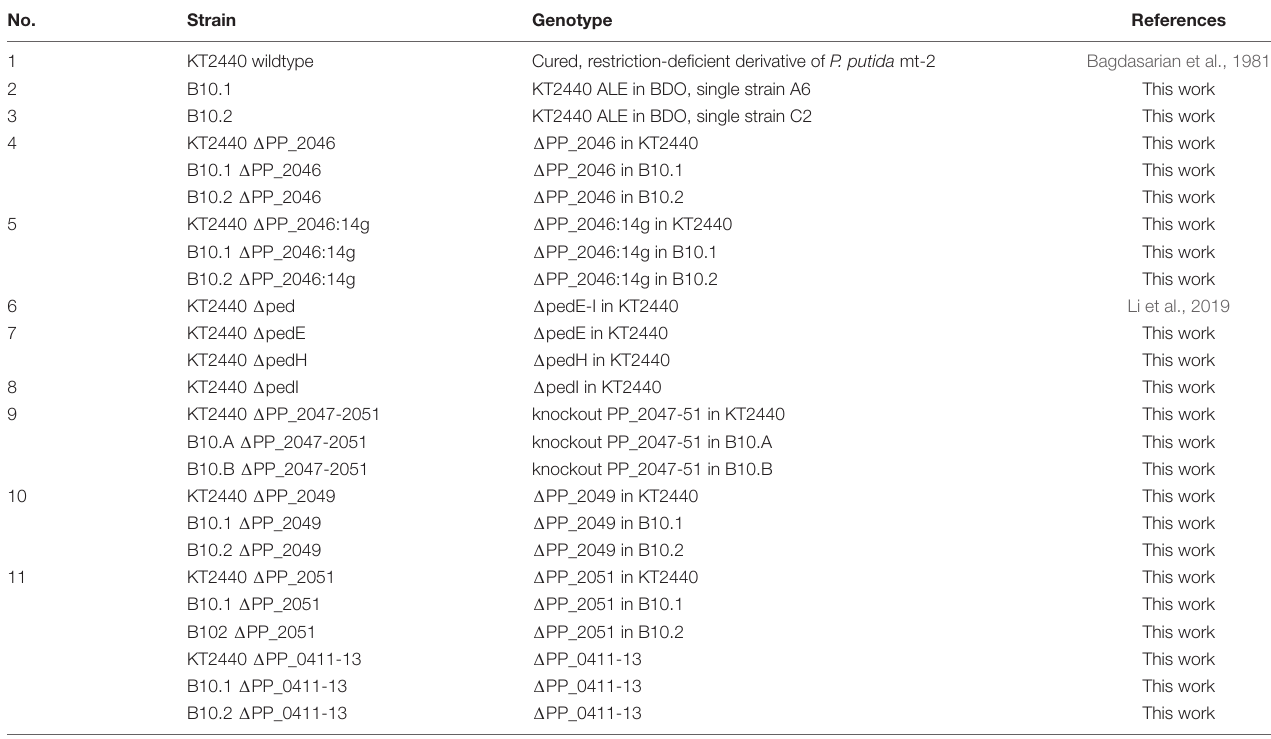
TABLE 1 | Pseudomonas putida strains used in this work with listed genotype and references.